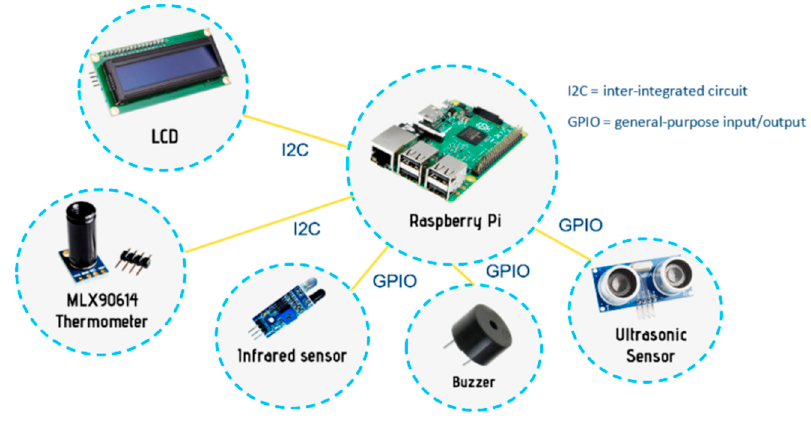
Figure 3. Connection of the Raspberry Pi to sensors and output devices.